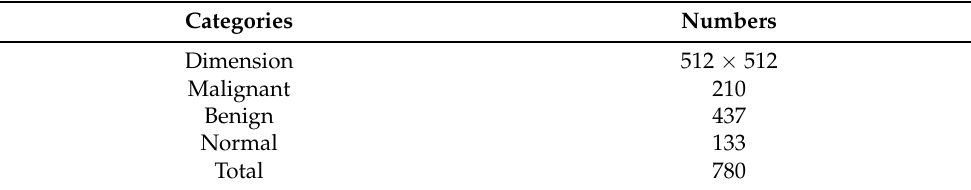
Table 2. Dataset Description.